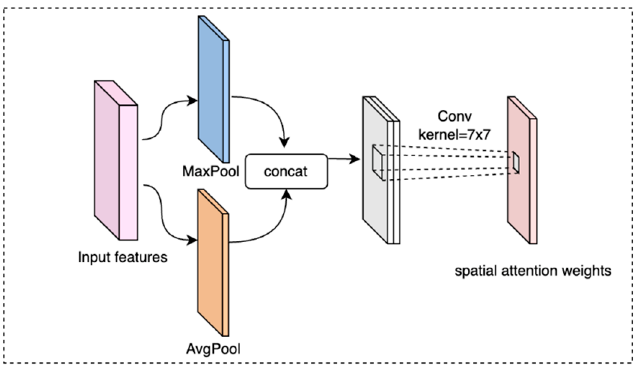
Figure 9. The structure of spatial attention.